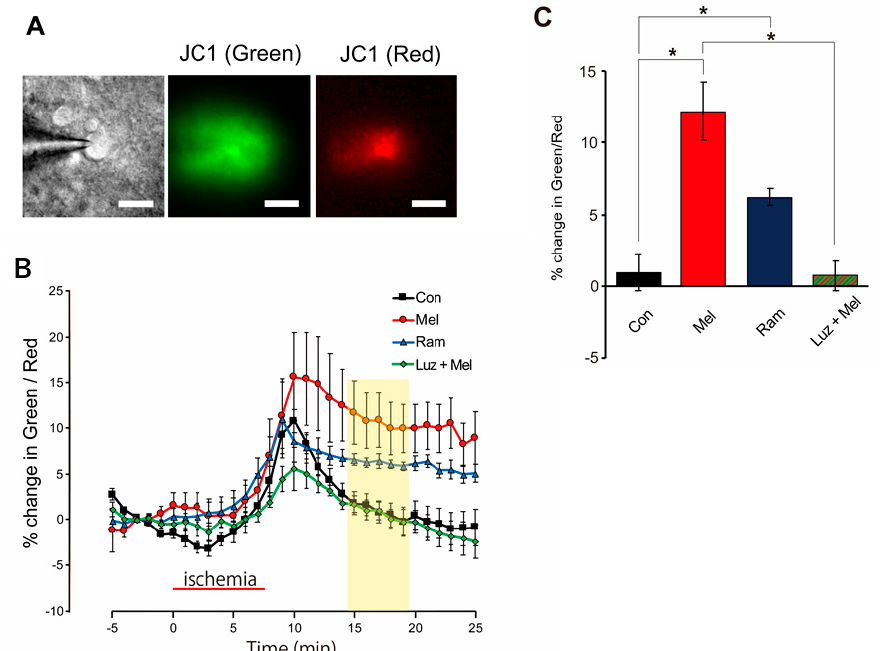
Figure 6. Changes in mitochondrial membrane potential as estimated from JC1 fluorescence during pre-ischemia, ischemic, and reperfusion periods. ( A ) Representative microphotographs of JC1 fluo- rescence in a slice of hippocampus: Left: infrared differential interference contrast image; Middle: green fluorescent image excited at 477 nm; Right: red fluorescent image excited at 548 nm. Scale bars = 10 μ m. ( B ) Course of changes in mitochondrial membrane potential estimated with JC1 fluores- cence during pre-anoxia, anoxia, and reperfusion periods. Percentages are relative to the mean value observed during the 5 min pre-anoxic period. The red horizontal bar indicates the ischemic period. The timeline in the graph set to 0 min at the start for the ischemic load. The yellow band represents the period used for statistical analysis. ( C ) Bar graph of percentage change in the JC1 green/red ratio, median data from the 7.5–12.5 min reperfusion period (yellow band in ( B )). Asterisks indicate sig- nificant differences in Games–Howell multiple comparisons test (* p < 0.05). Con—control; Mel— melatonin; Ram—ramelteon; Luz—luzindole.